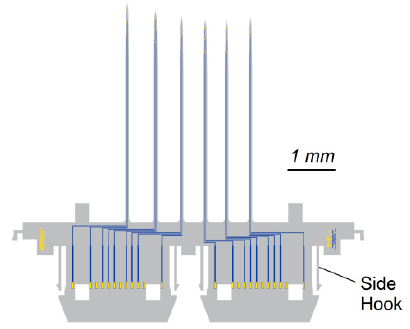
Figure 6. Design drawing of a 2-D insert with side-hooks.